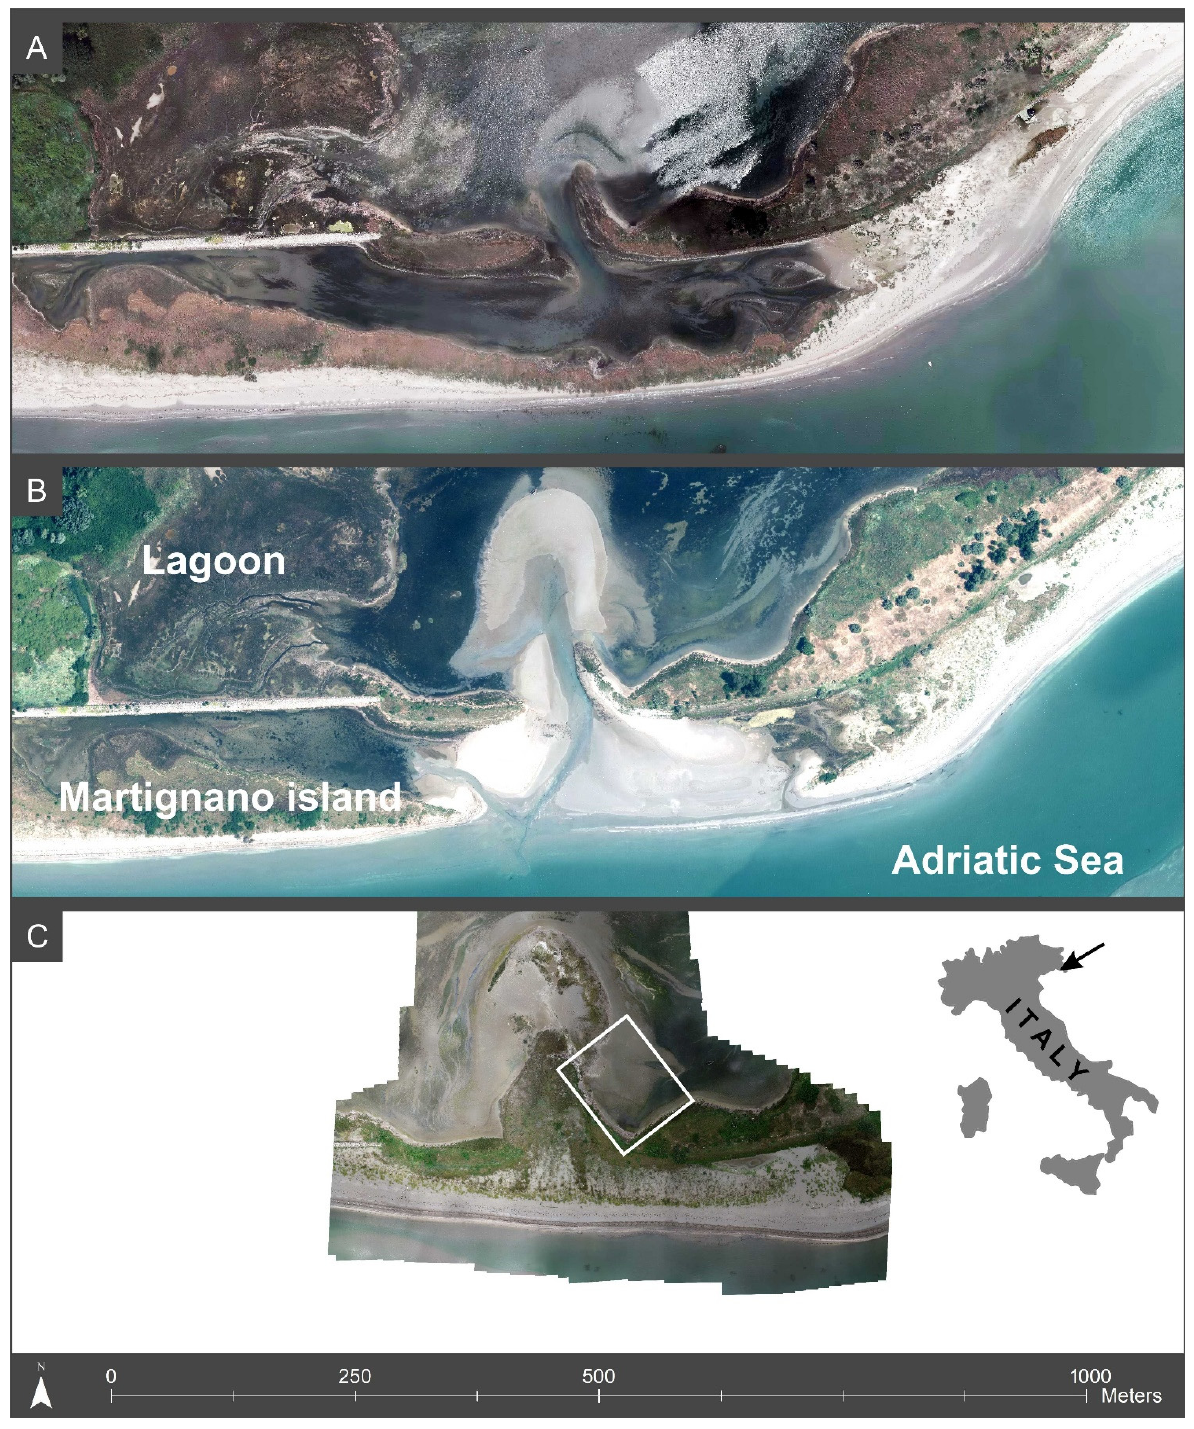
Figure 3. A sequence of aerial photographs depicting the morphological changes involving the Martignano barrier island (Marano and Grado Lagoon, Italy). 2012 ( A ) shows that the beach is continuous. A washover channel and a washover fan are clearly visible in 2014 ( B ). The washover channel is totally filled and the beach has reverted to its usual linear configuration in 2021 ( C ) (UAV photogrammetric survey); the white box indicates the area surveyed by UAV in 2022 (centroid Coordinates: 45°42 ′ 17.80 ″ N; 13°10 ′ 04.62 ″ E).